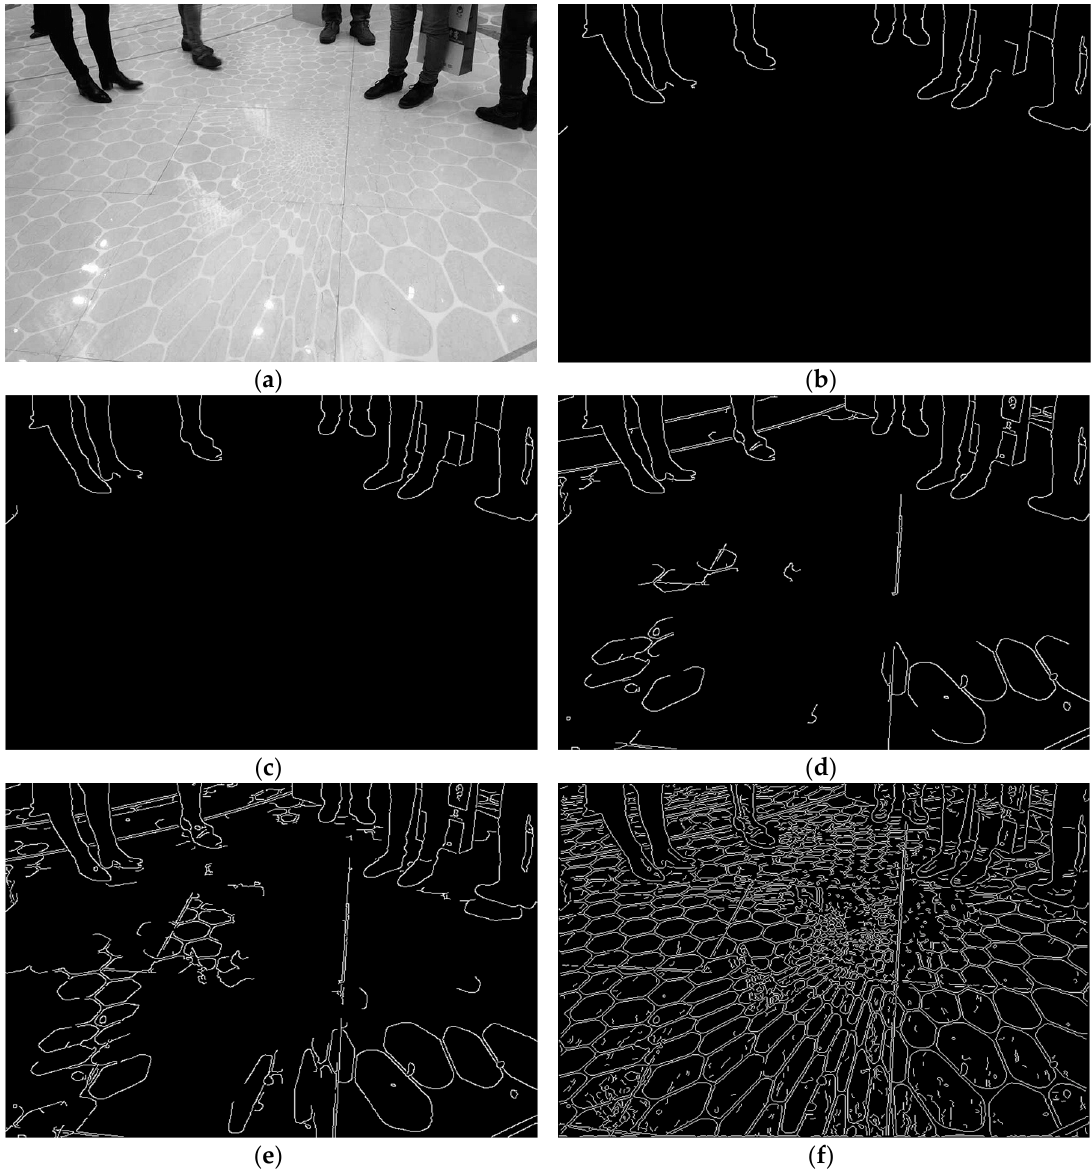
Figure 16. Embossed tile image comparison results of different methods. ( a ) Original image (640 × 480) [21]; ( b ) Gao and Liu’s method (TH H = 238, TH L = 119); ( c ) Song et al. proposed method (TH H = 238, TH L = 20); ( d ) Saheba et al.’s method (TH H = 102, TH L = 31); ( e ) Li and Zhang’s method (TH H = 74, TH L = 29); ( f ) TCEDA.